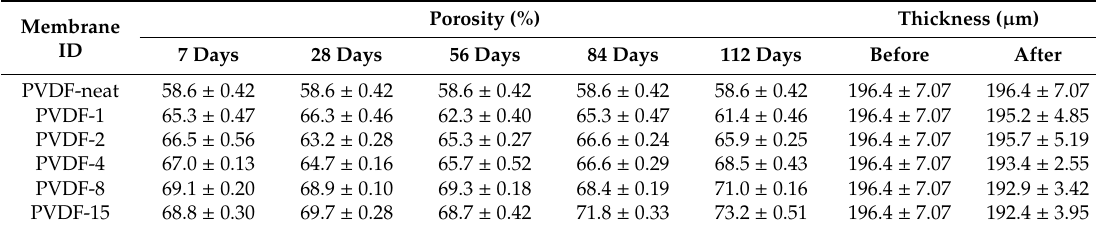
Table 1. Membrane porosity and